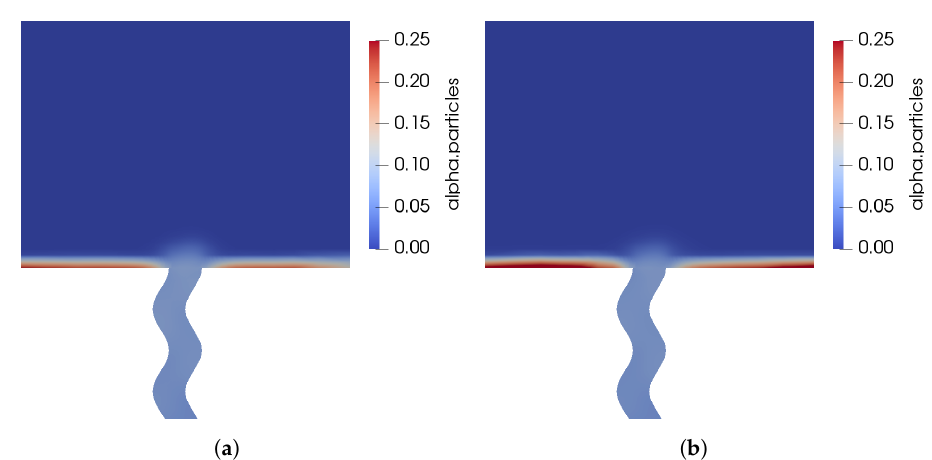
Figure 16. Effect of the rotational speed of the gravity vector on the volume fraction field. ( a ) W = 1 mm at t = 5 s, f = 20 Hz, a = 1.25 mm, θ = 10 deg, ω = 0.1 rad/s. ( b ) W = 1 mm at t = 5 s, f = 20 Hz, a = 1.25 mm, θ = 10 deg, ω = 1